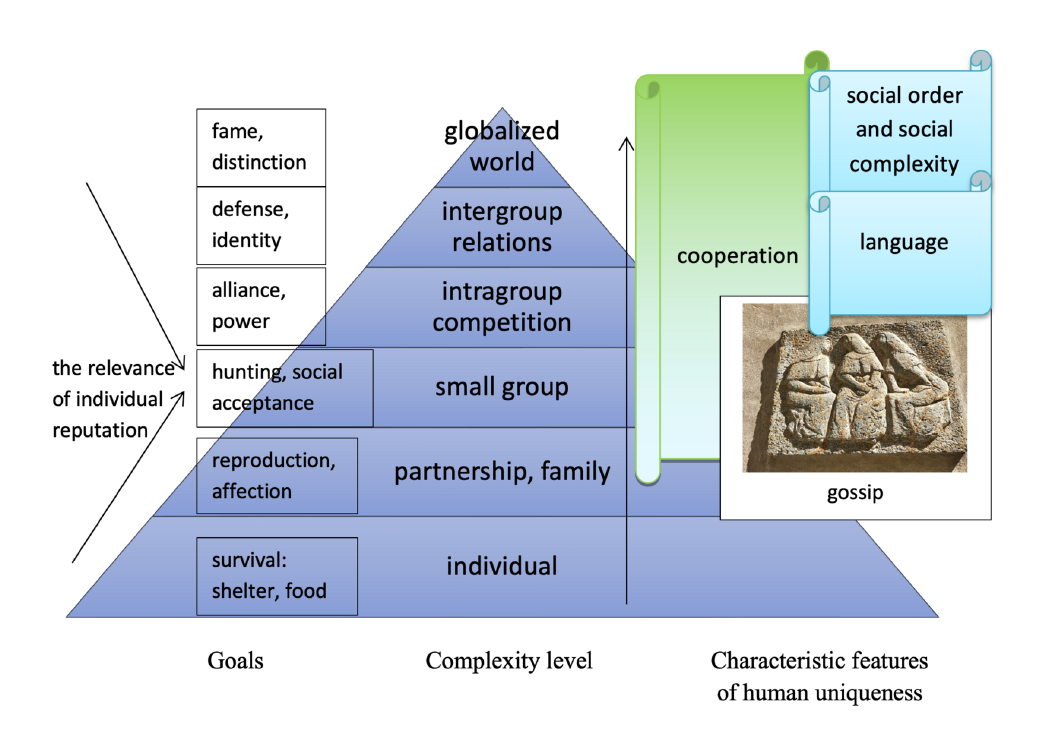
Figure 1. Reputation and the increasing complexity of human social